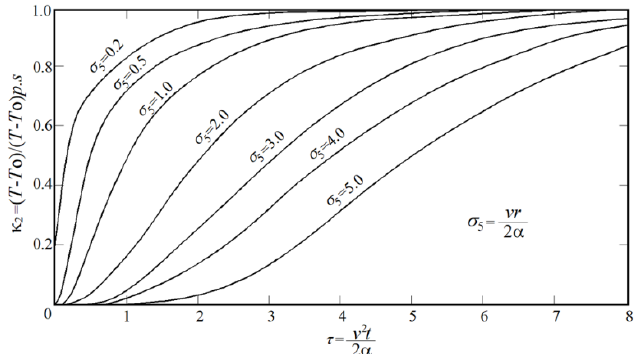
Figure 11. Ratio between real and pseudo-steady state temperature in thin plate welding for different combinations of σ 5 and τ [5].